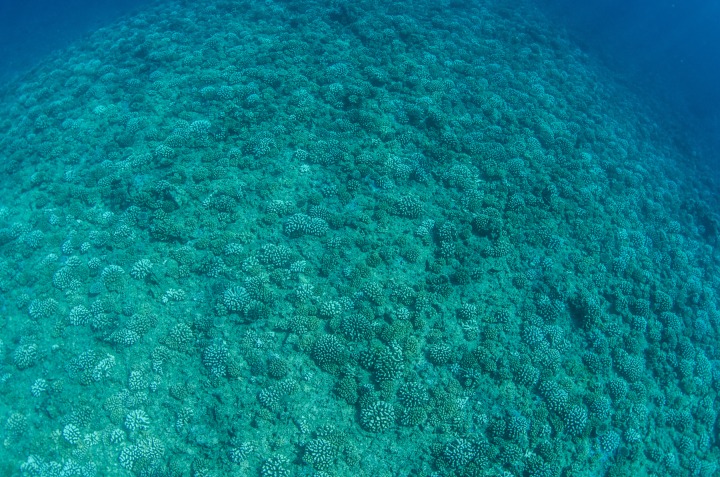
The outer reef on the north shore of Moorea in April 2015.This reef is at ∼12 m depth and the image shows the high density of pocilloporid corals that have grown since 2010.